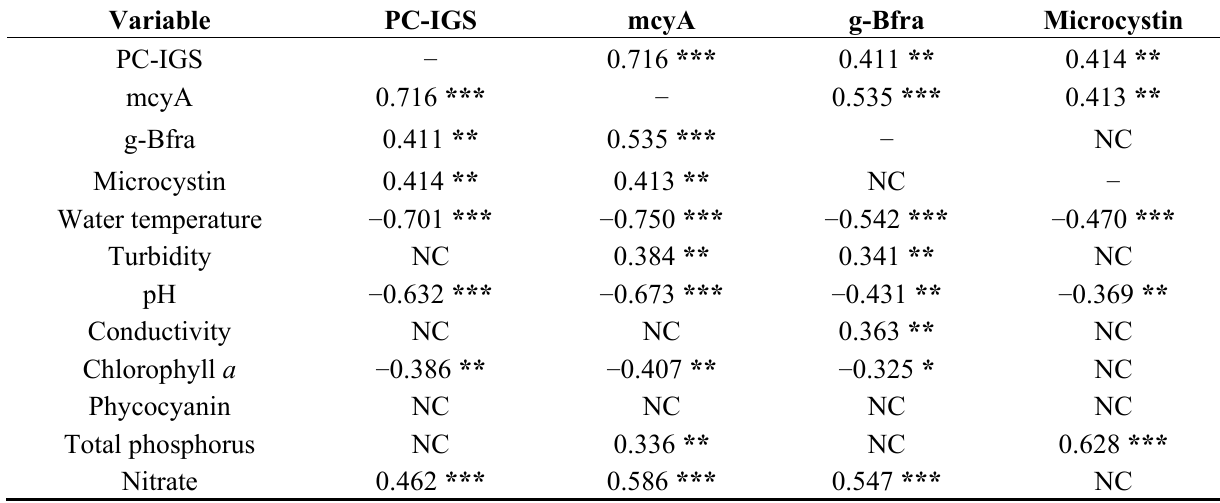
Table 3. Summary of Spearman correlation coefficient showing significant relationships among qPCR measurements, microcystin, and water quality parameters.